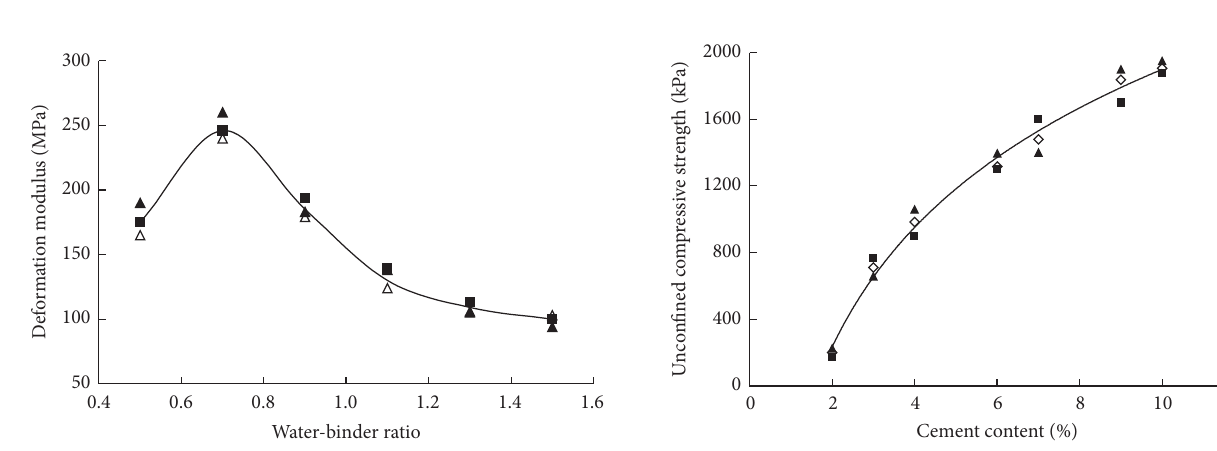
Figure 10: Variation of deformation modulus for different water- binder ratios.